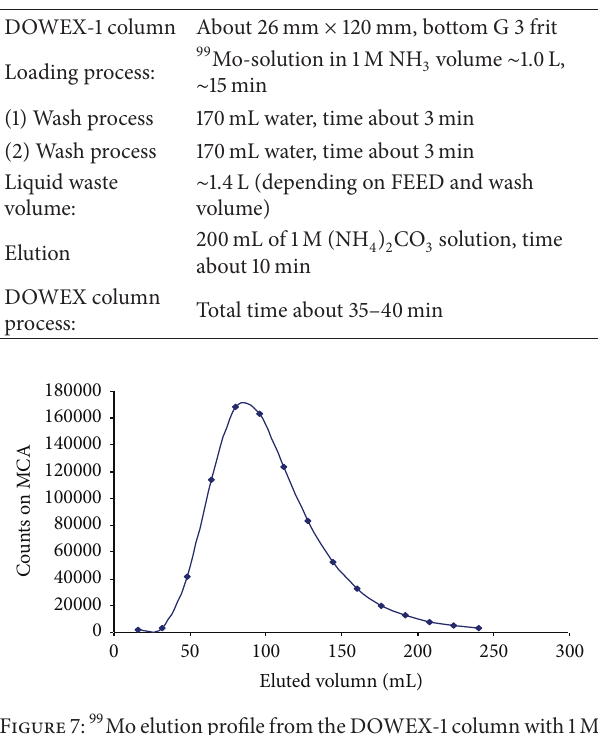
FEED solution (filtrate after iodine removal), from the final product illustrating the different separation and purification steps (for more details see